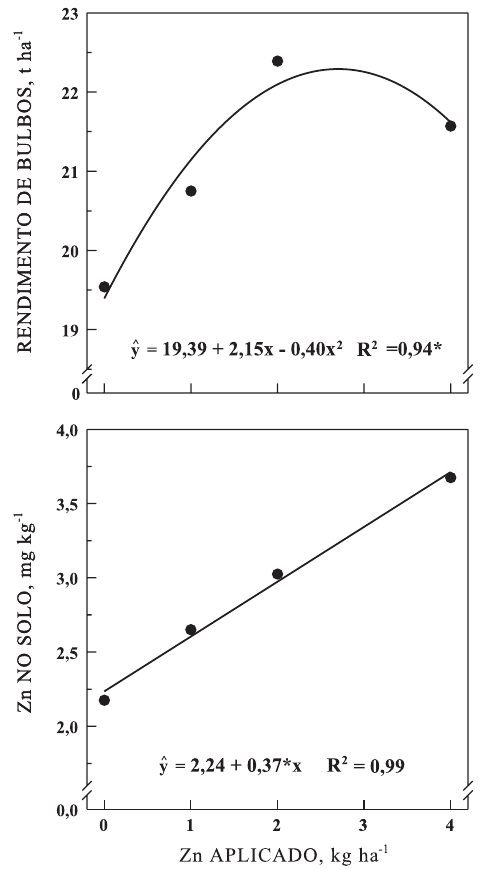
Figura 1. Produtividade de bulbos de cebola e teor de Zn no solo na safra 2006/2007, em função da adição de doses crescentes de Zn ao solo antes do plantio. Média de quatro repetições. * Significativo (p < 5